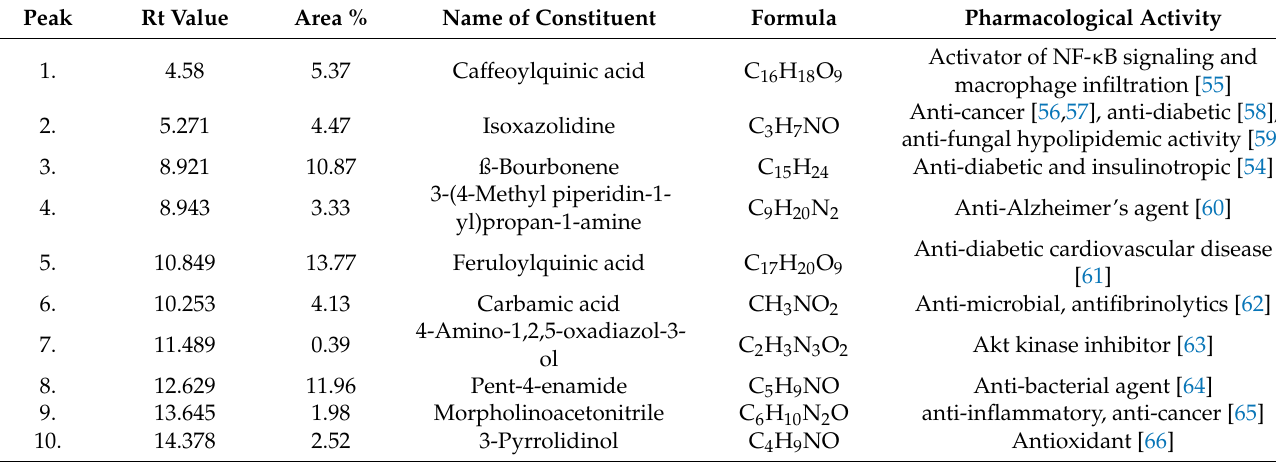
Table 3. Structure of some major compounds identify in GC/MS analysis and their biological activity of ethyl acetate fractions of H. tuberosus